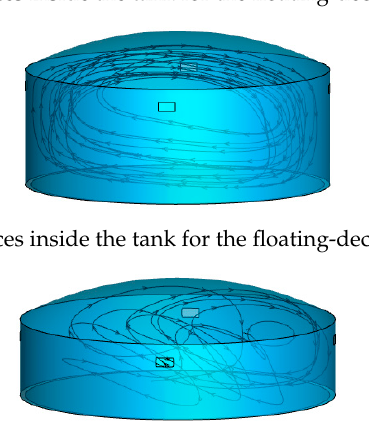
Figure 6. Streamtraces inside the tank for the floating-deck height of 5.63 m.